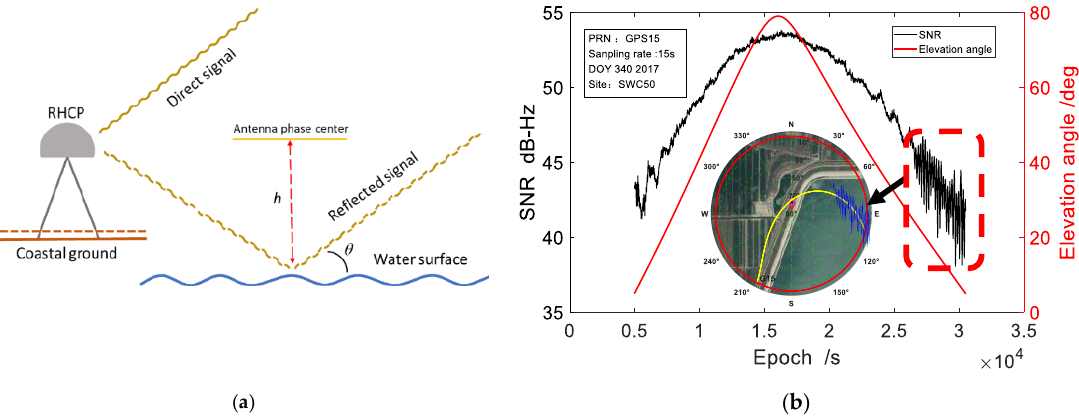
Figure 1. ( a ) Schematic diagram of GNSS-IR water level monitoring, ( b ) The relation between the signal-to-noise ratio and azimuth and elevation angle in the direction of water area.